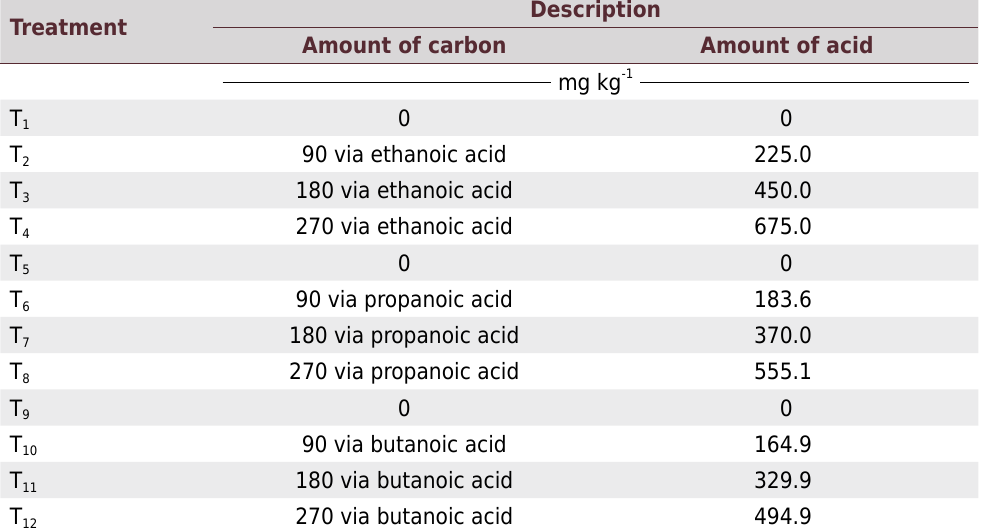
Dose values were based on preliminary tests and values found by Sousa et al.